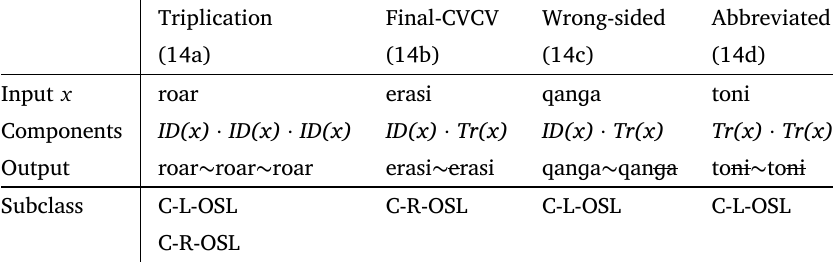
Table 4: C-OSL treatment for less common reduplication patterns